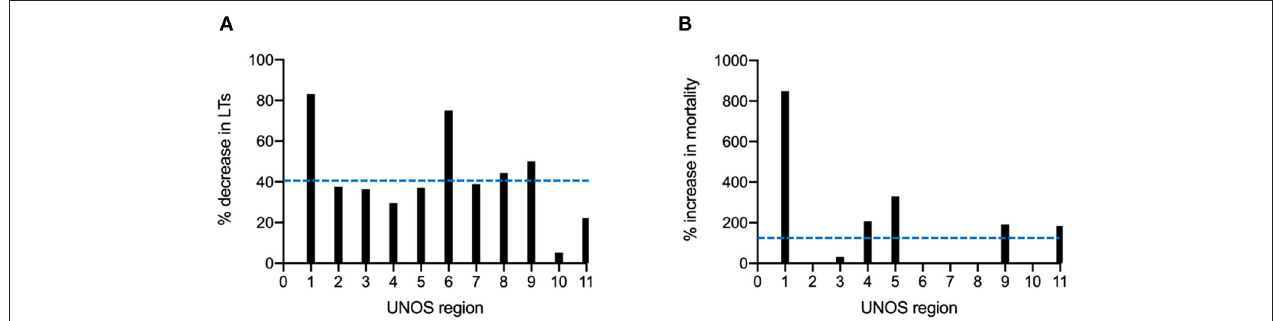
FIGURE 2 | Regional variation in liver transplantation during the COIVD-19 pandemic in the United States. (A) Percent decrease in LTs performed from week 10 to 15 of 2020, stratified by the United Network for Organ Sharing (UNOS) region. (B) Percent increase in candidate LT waitlist mortality from week 10 to 15 of 2020, stratified by UNOS region. Dashed blue lines represent means across all 11 UNOS regions.